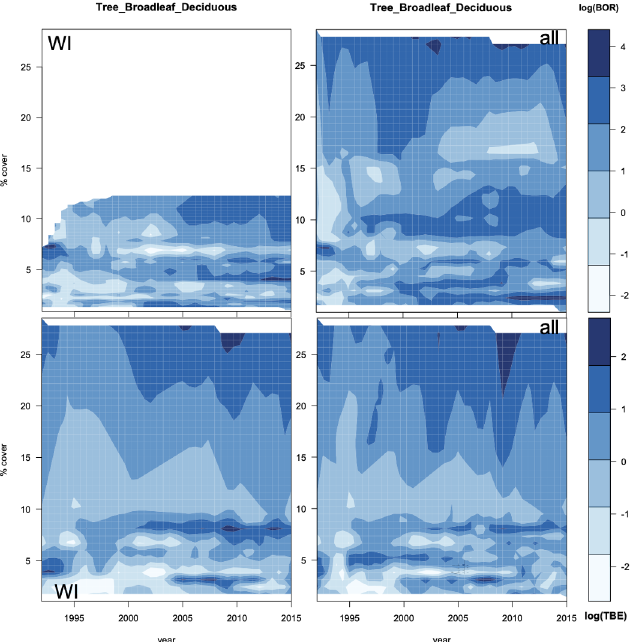
Figure 9. Interpolations for the log of incidence of BOR ( top ) and TBE ( bottom ) with respect to the percentage cover of yearly evolution of broadleaf deciduous trees for ( left ) the WI districts and ( right ) all